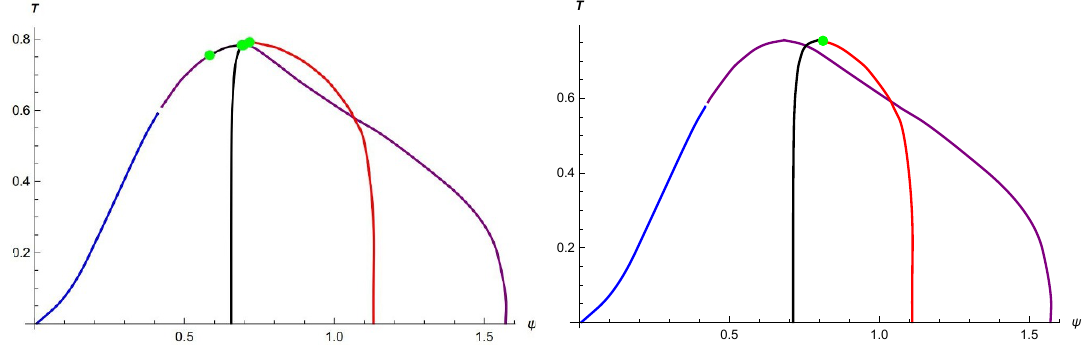
Figure 6 . On the left, we plot the temperature of all the static M5-brane con(cid:12)gurations as a function of their position on the four-sphere at (cid:12)xed p= ~ M = 0 : 01. The color conventions are explained in the main text. There is a single fat-thin merger in this regime represented by the green dot. On the right, we plot the temperature of all the static M5-brane con(cid:12)gurations as a function of their position at (cid:12)xed p= ~ M = 0 : 03. This is still a phase diagram in regime I.